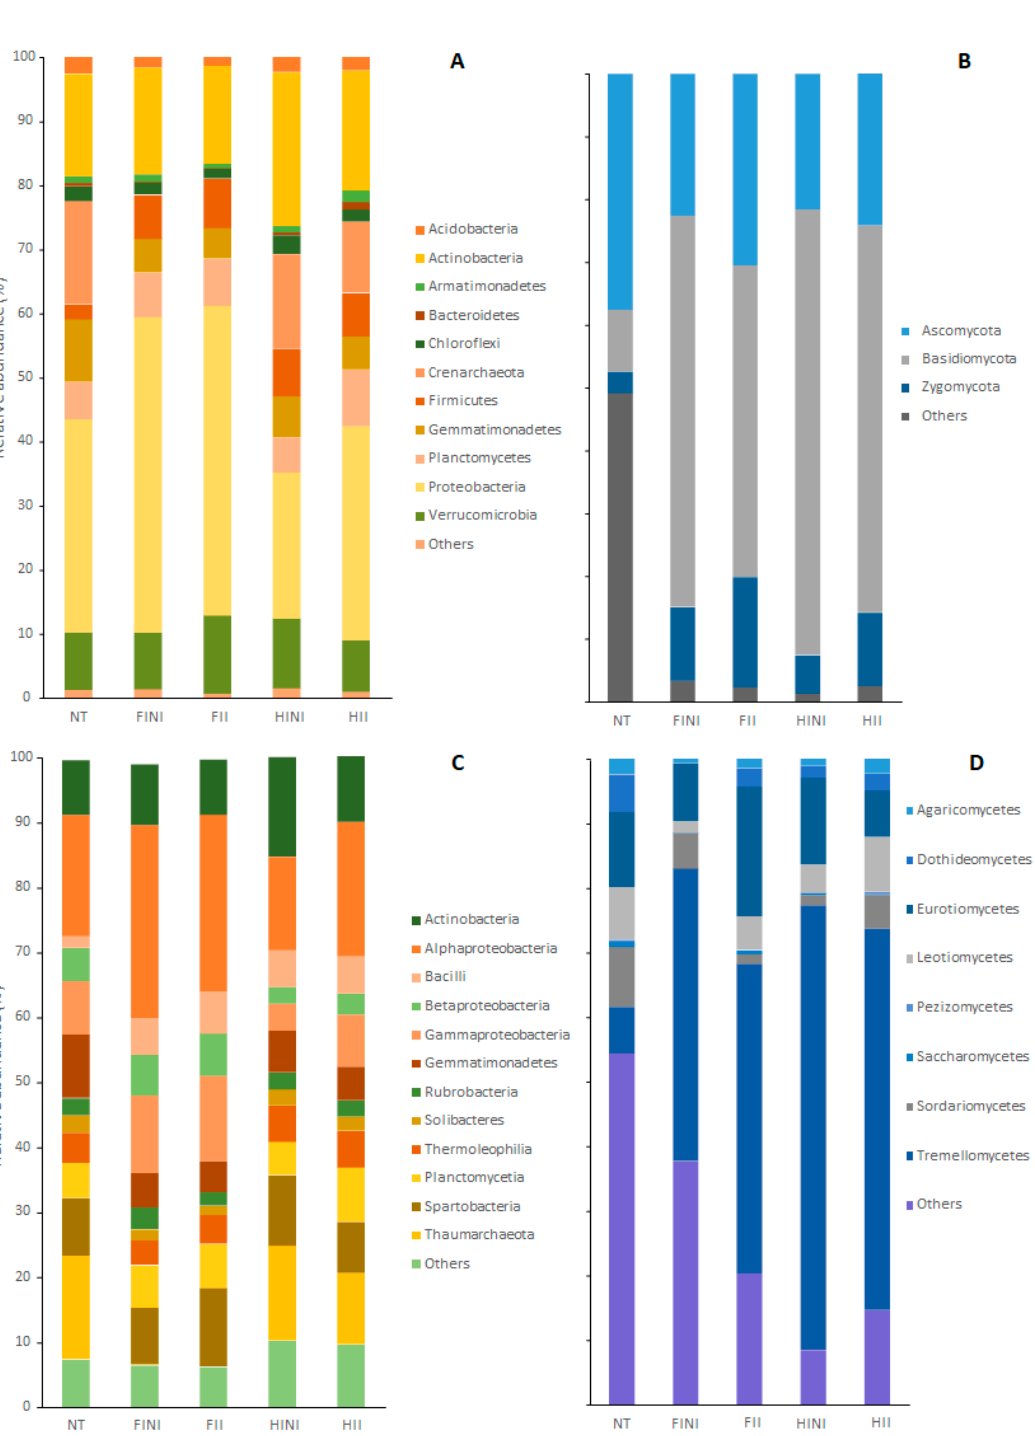
Figure 3. Bacterial and fungal community composition found in plots before (NT) and after treatments, different irrigation amounts (FI, full irrigated, or HI, half irrigated), AMF inoculation (I, inoculated, or NI, non-inoculated), and their combination at phylum ( A , B ) and class ( C , D ) levels.